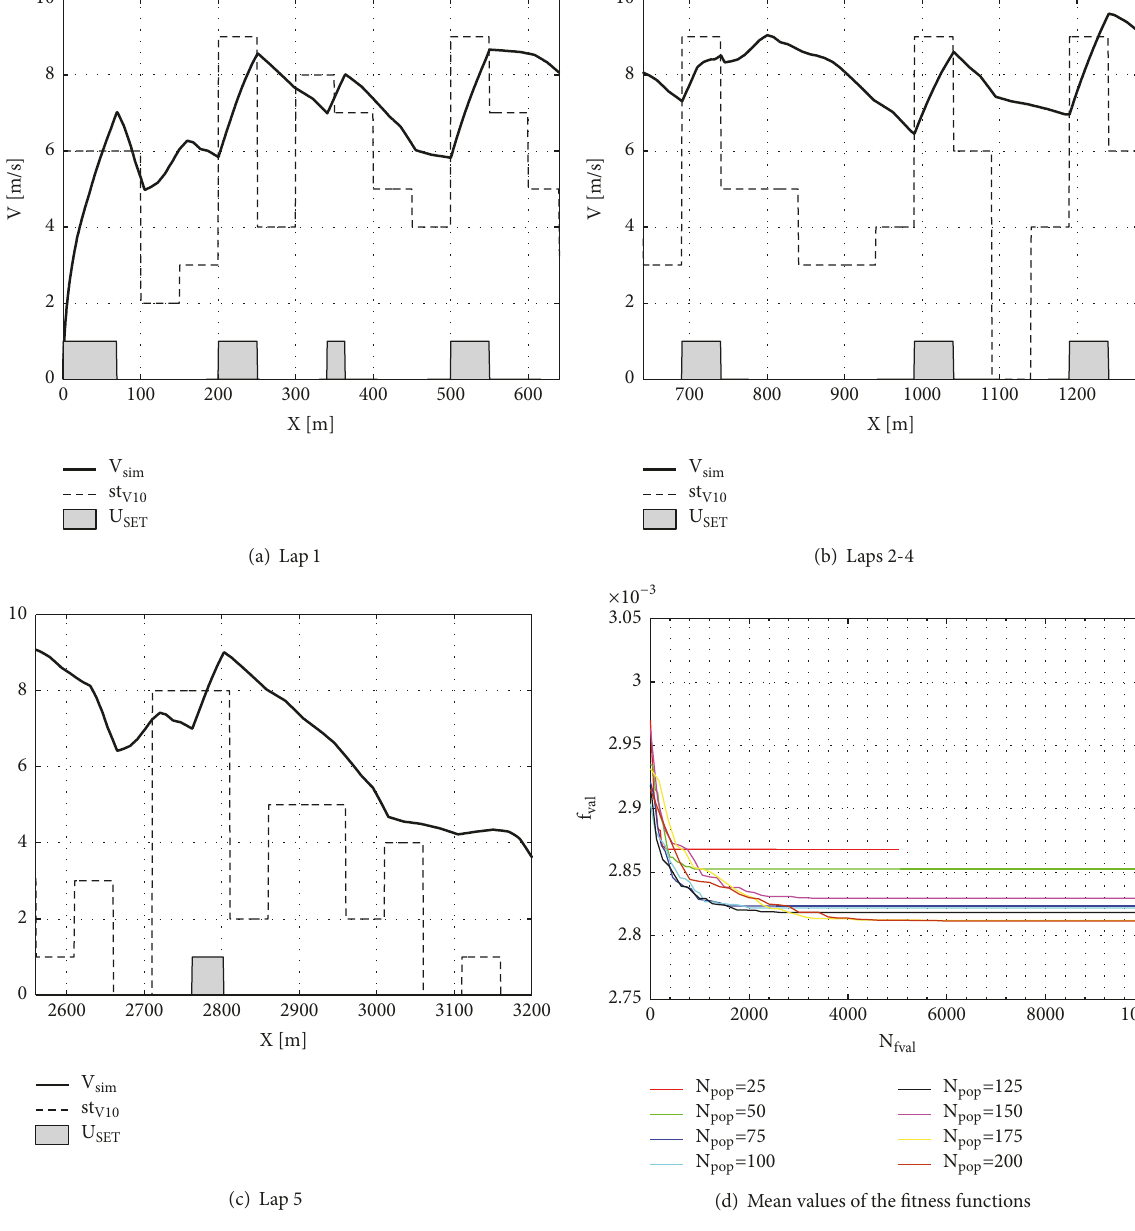
Figure 18: Vehicle speed and control signal st 𝑉10 for route